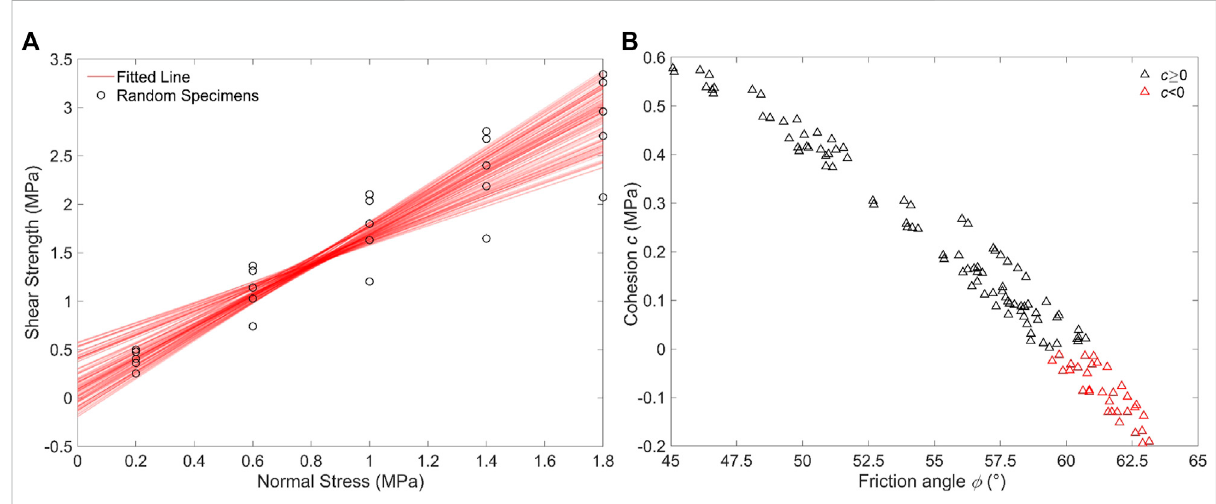
FIGURE 7 Shearstrengthparametersfor5specimensunder120permutationsofnormalstressassignments. (A) Linear fi ttedlineswiththeMohr-Coulomb criterion; (B) Scatter plot of the captured apparent cohesion and friction